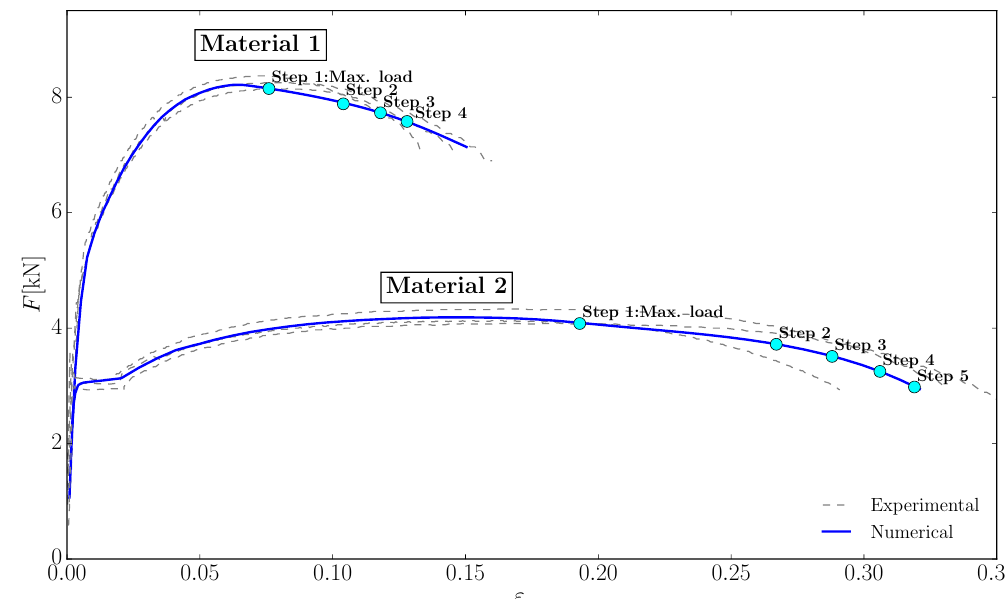
Figure 8. Load-strain curve of the 3 mm-diameter specimen of both materials; comparison between the experimental results and the numerical models. The steps used for the damage evolution analysis are represented with blue circles (the engineering strain has been obtained using an initial gauge length of 12.5